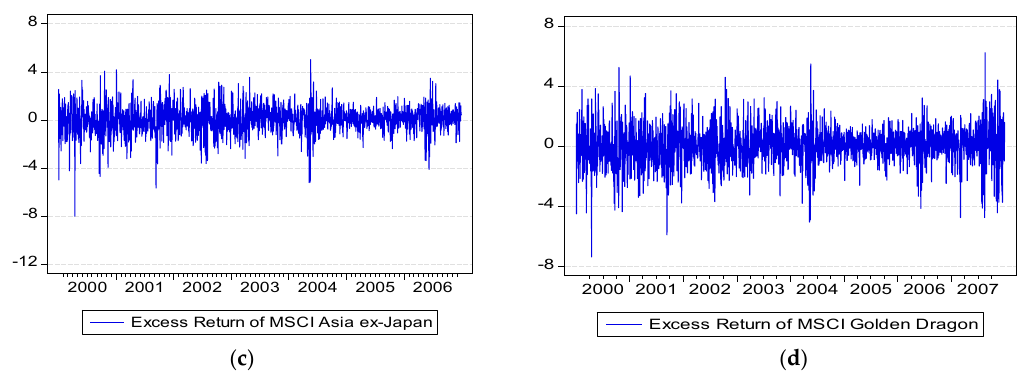
Figure 1. Daily excess returns of markets: ( a ) MSCI Japan; ( b ) MSCI World; ( c ) MSCI Asian ex-Japan and ( d ) MSCI Golden Dragon.